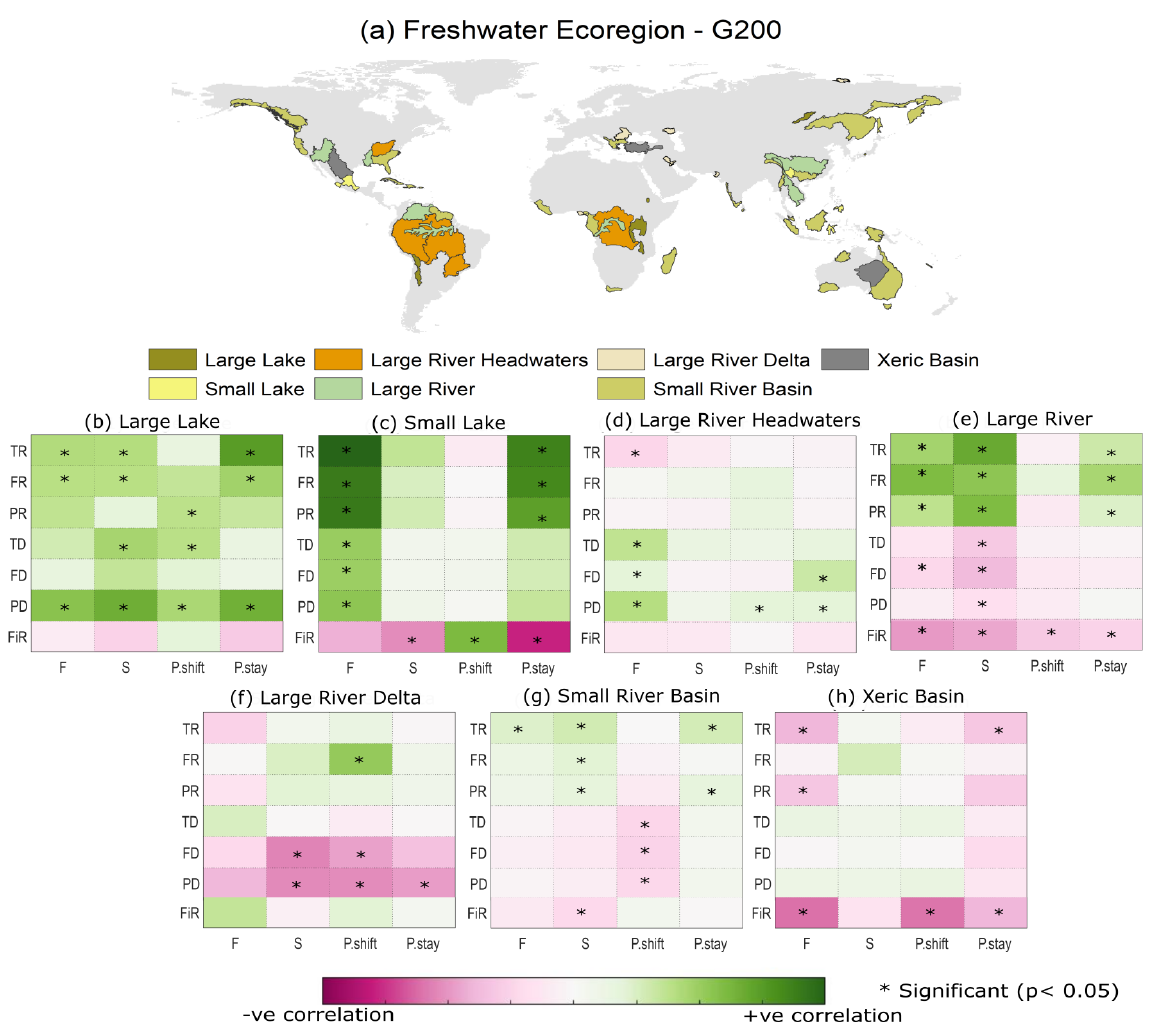
Figure 4. (a) Spatial distribution of different G200 freshwater ecoregions and (b–h) the correlation between EF violation indices and fresh- water biodiversity indicators for different G200 freshwater ecoregions. Note: the results for all the WWF freshwater ecoregions are given in the Supplement (Sect. S7). Abbreviations: F – frequency of violation; S – severity of violation; P.shift – probability of shifting to a vio- lated state; P.stay – probability of staying in a violated state; FiR – fish richness; TR – taxonomic richness; FR – functional richness; PR – phylogenetic richness; TD – taxonomic dissimilarity; FD – functional dissimilarity; PD – phylogenetic